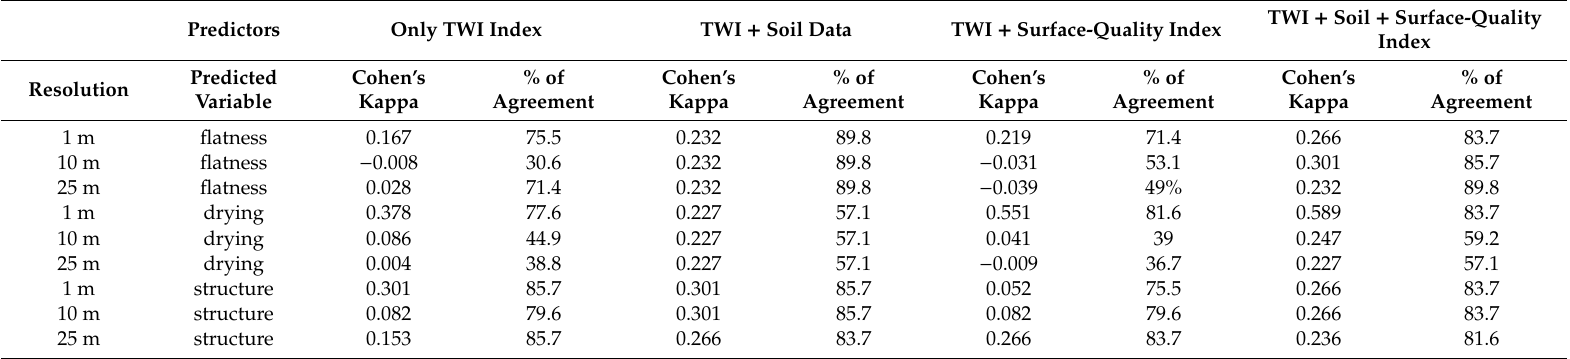
Table 4. Correctness of classification, using two road-quality classes (poor and non-poor) and various combinations of predictors, such as the wetness index, soil data and surface-quality